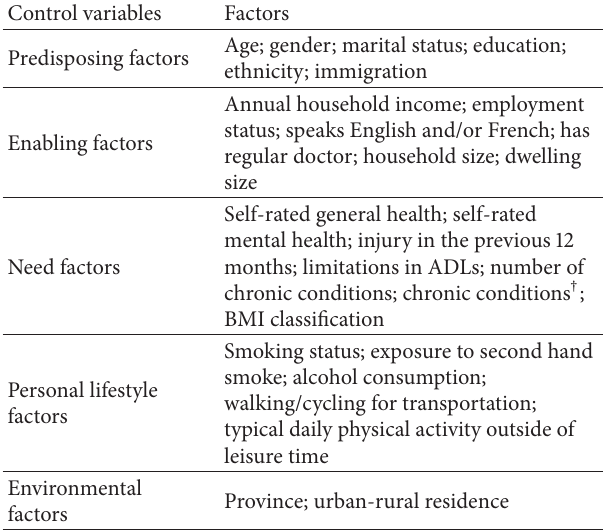
Table 1: Predisposing, enabling, health need, personal health prac- tices, environmental, and community control variables included in the multivariate